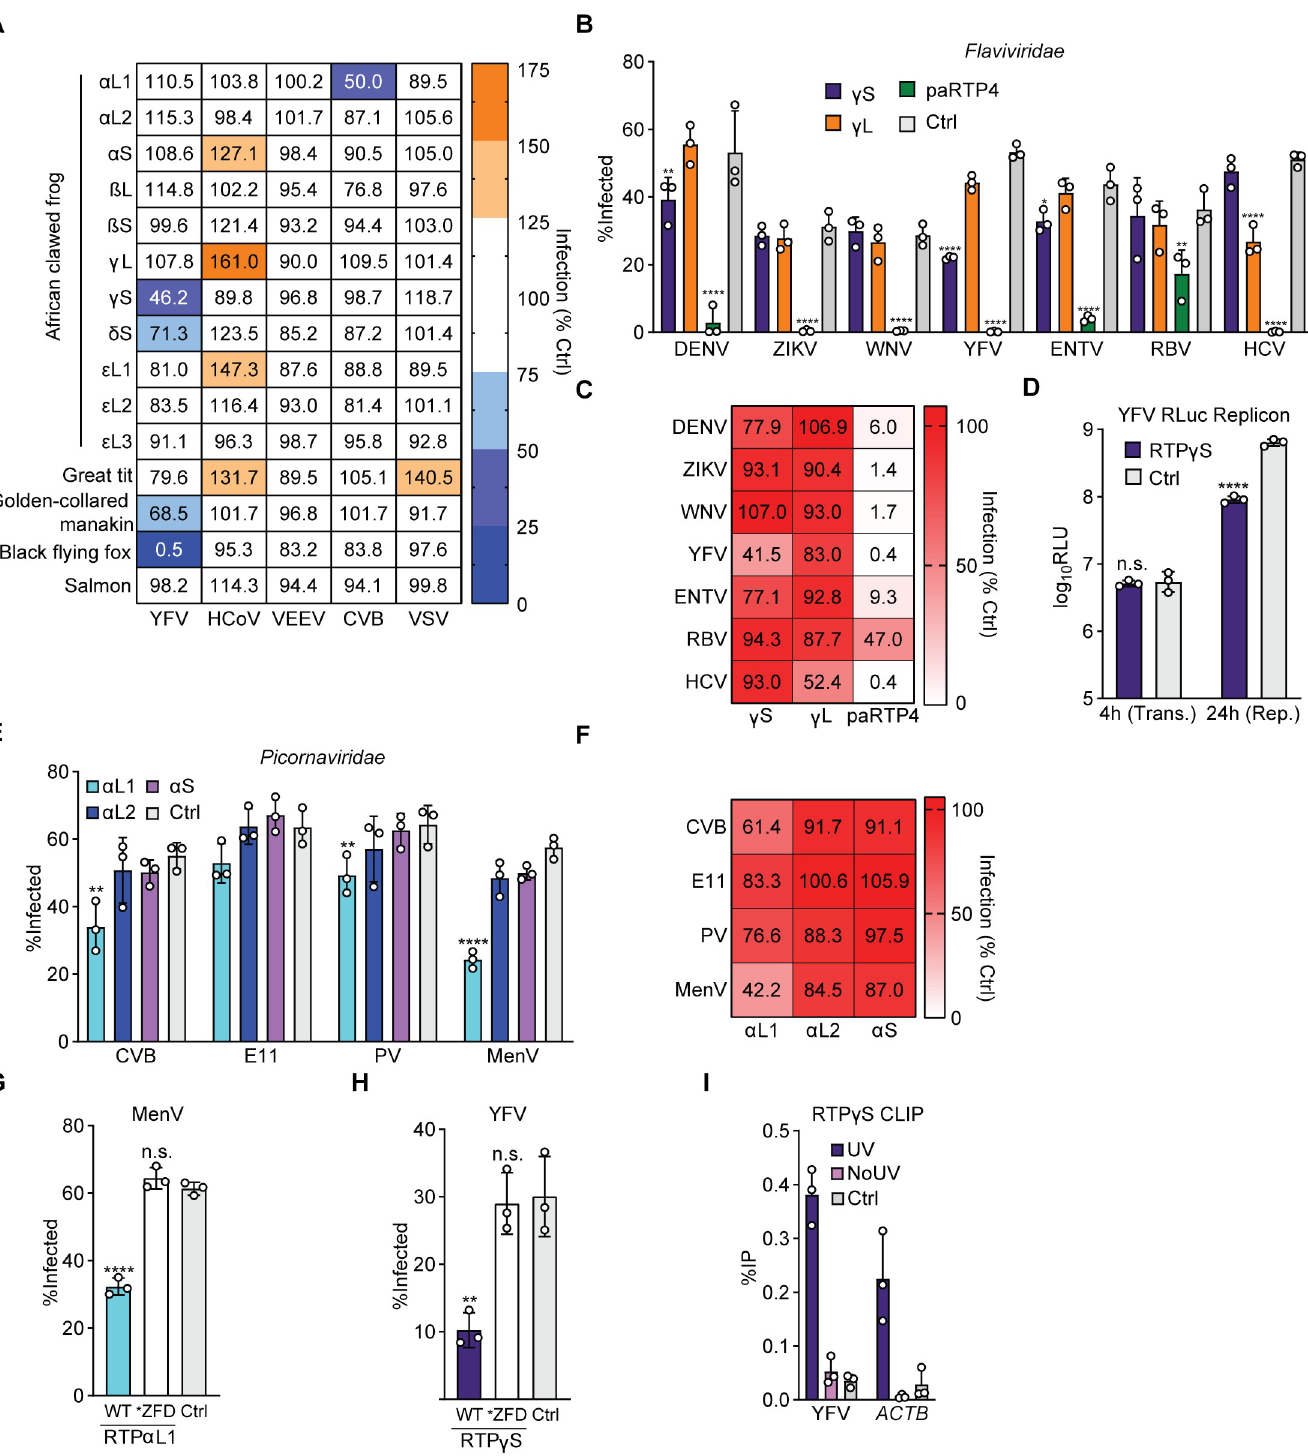
PLOS Genetics | https://doi.org/10.1371/journal.pgen.1009578 May 20,